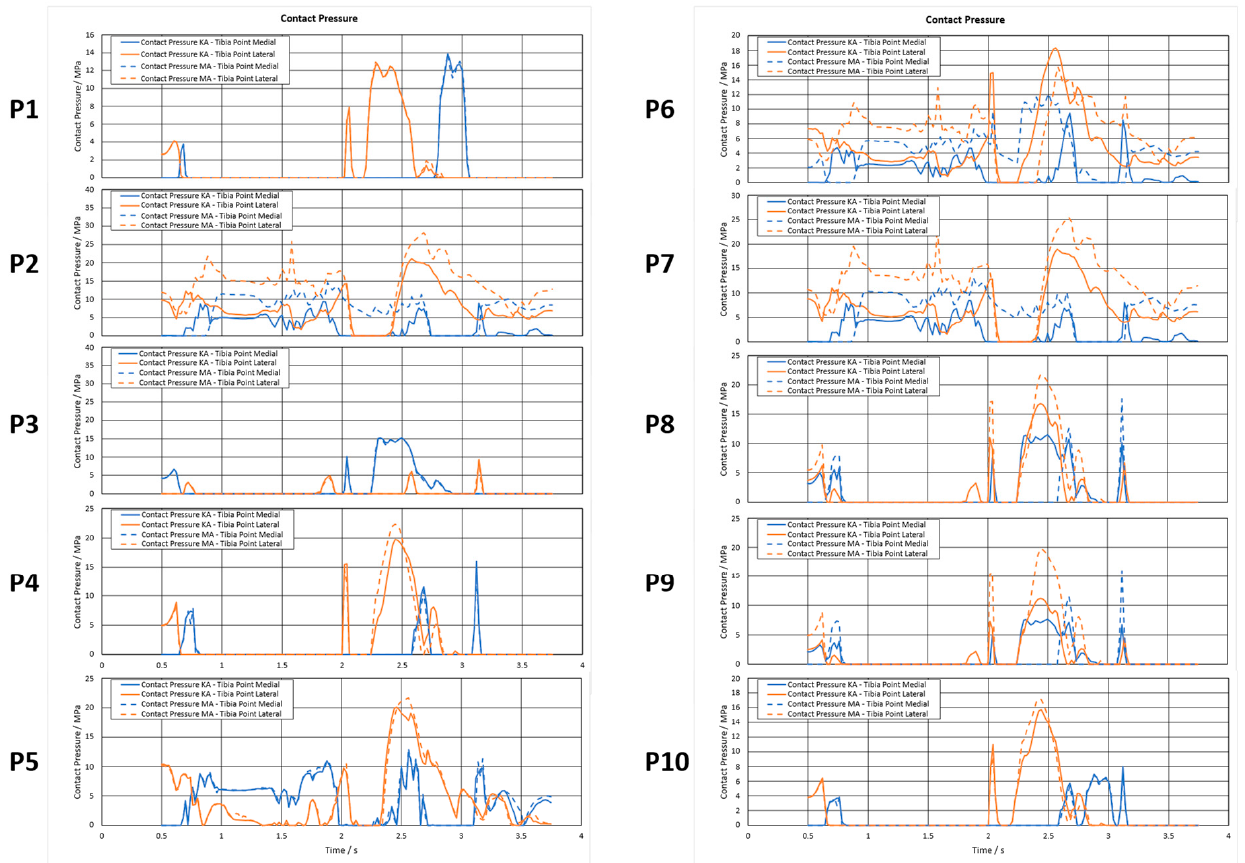
Figure 3. Contact Pressure evolution in MPa over one gait cycle, comparing medial/lateral points and KA/MA.